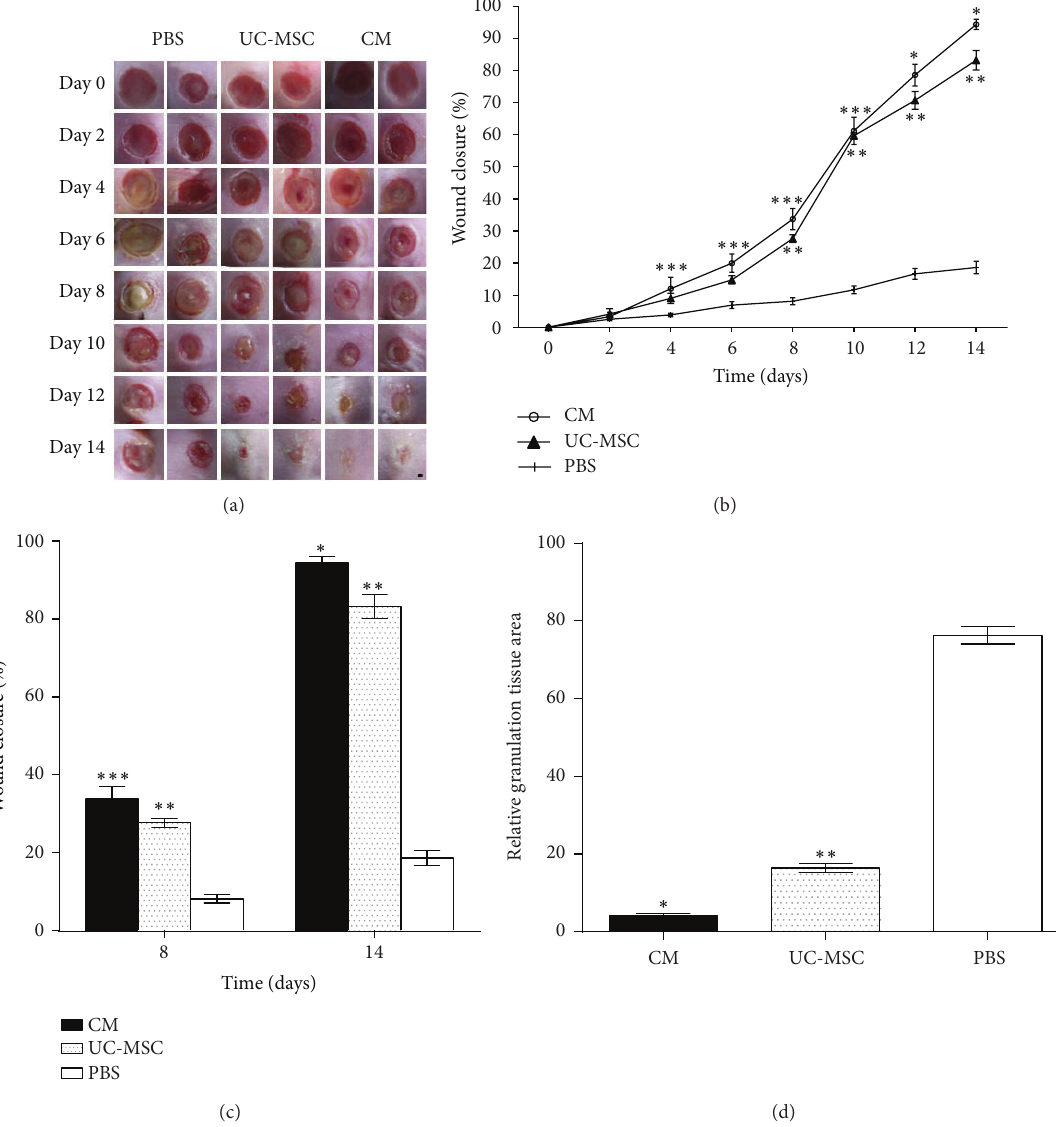
Figure 1: Effects of CM, UC-MSC, and PBS on wound closure. (a) Representative photographs of the wounds of every alternate day from day 0 to day 14 after injury. Scale bar is 1mm. (b) Comparison of wound closure rates expressed as a percentage of its initial wound area every alternate day after wounding ( 𝑛 = 6 ; ∗ 𝑃 < 0.05 , CM versus UC-MSC or PBS); ( 𝑛 = 6 ; ∗∗ 𝑃 < 0.05 , UC-MSC versus PBS); ( 𝑛 = 6 ; ∗∗∗ 𝑃 < 0.05 , CM versus PBS). (c) Wound measurement of all groups at day 8 and day 14 ( 𝑛 = 6 ; ∗ 𝑃 < 0.05 , CM versus UC-MSC or PBS); ( 𝑛 = 6 ; ∗∗ 𝑃 < 0.05 , UC-MSC versus PBS). (d) Relative granulation tissue area of wounds treated with CM, UC-MSC, and PBS at day